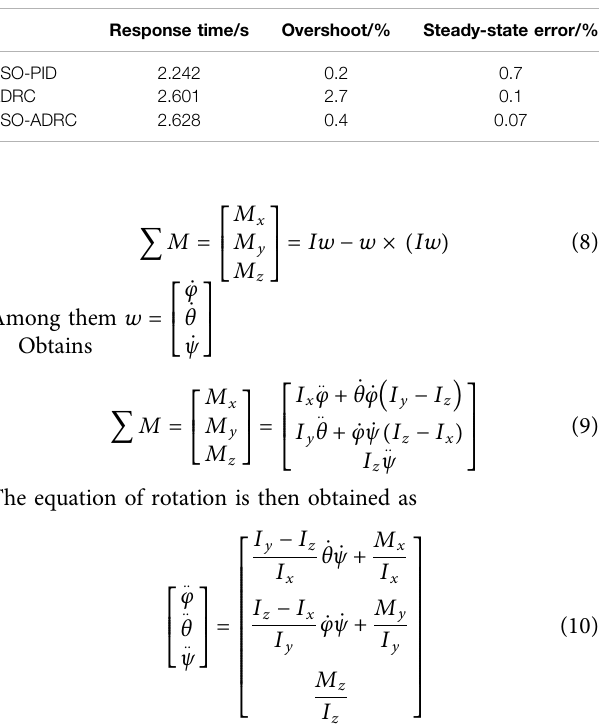
TABLE 2 | Tracking effect with external interference.